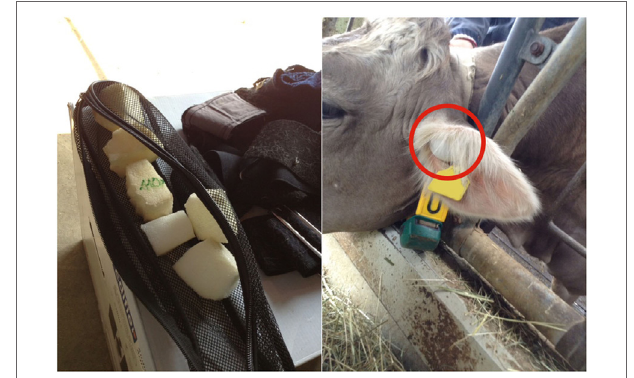
FigUre 1 | Technical equipment. Technical equipment behind a visual cover of white fabric. C, camera; S, speakers; X, experimenters were hidden behind the visual cover during